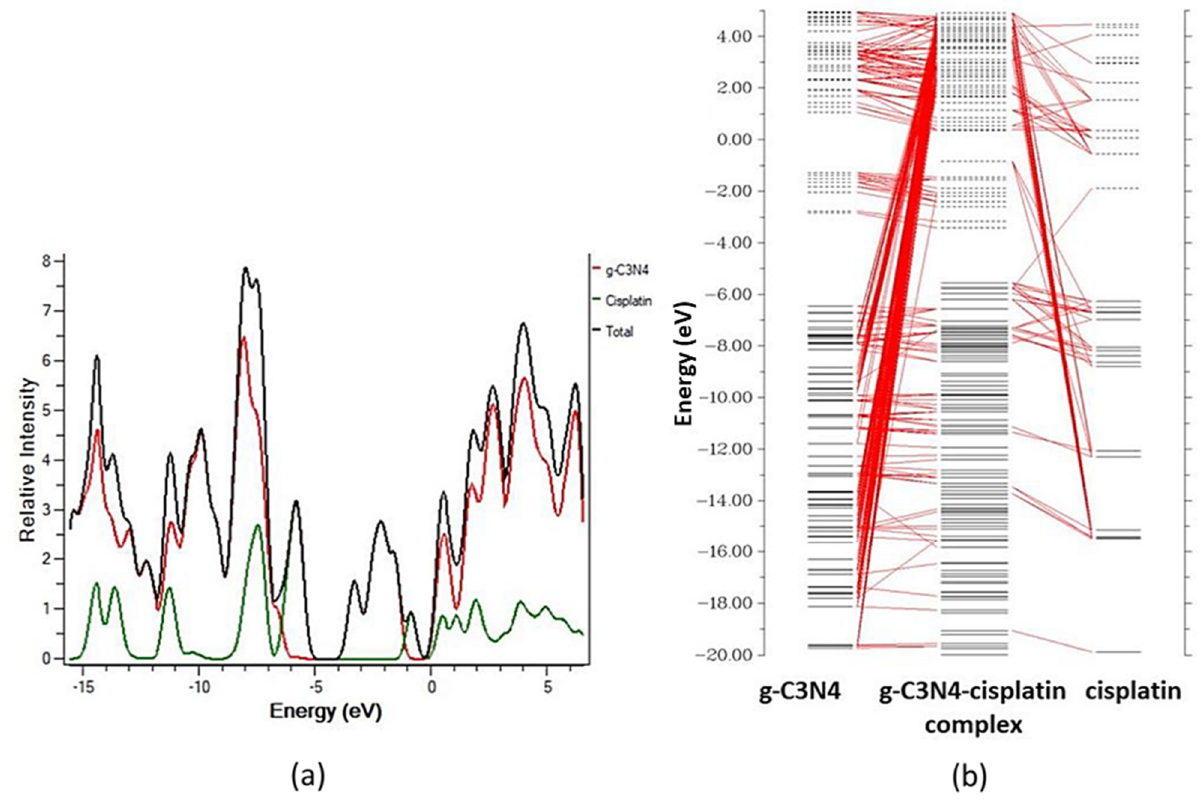
Figure 7. ( a ) g-C3N4, cisplatin, and the g-C3N4–cisplatin complex DOS spectra; ( b ) CDA of the